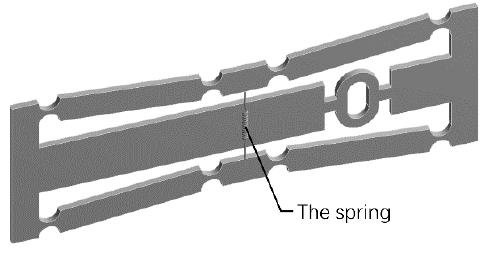
Figure 7. Dynamic simulation model.